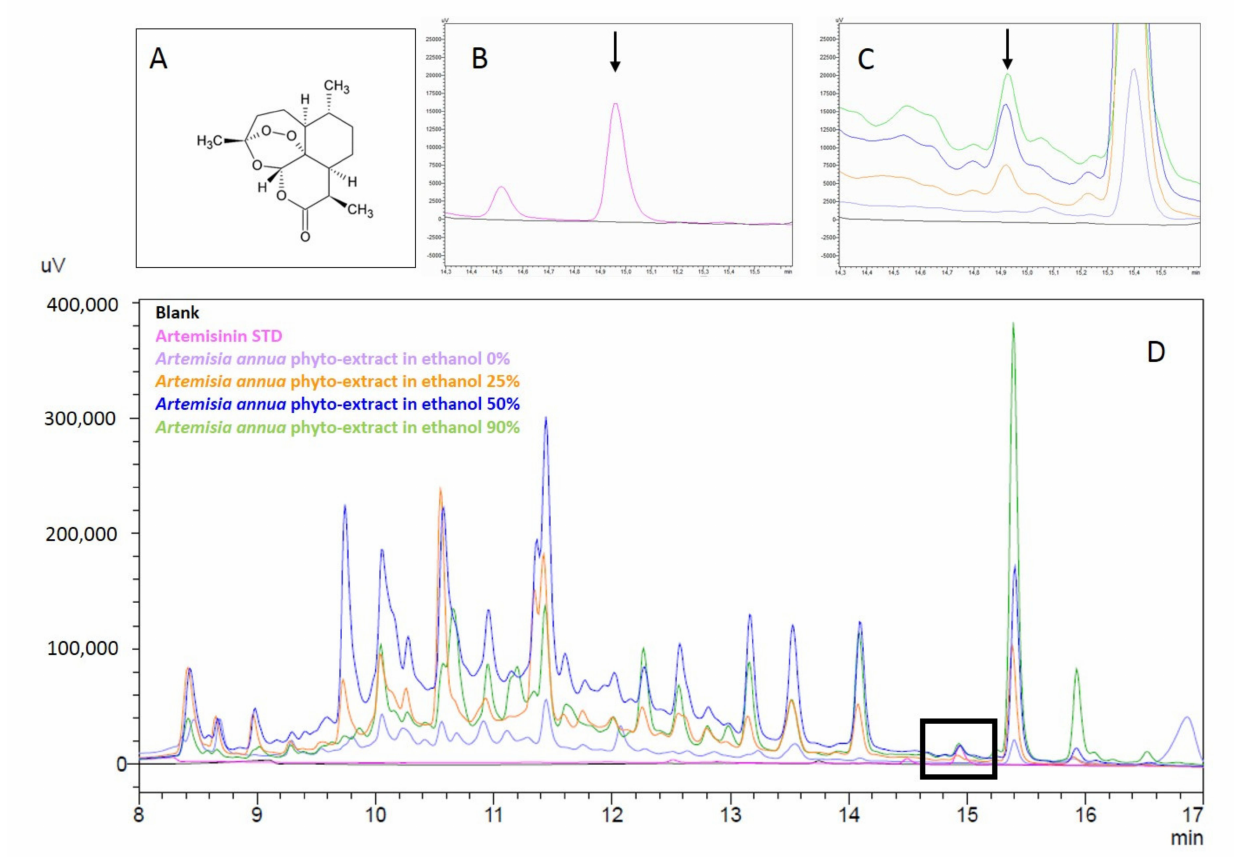
Figure 2. Chromatograms of the phyto-extracts of Artemisia annua and of the standard artemisinin. ( A ) Chemical structure of artemisinin; ( B ) details of the elution of STD artemisinin (pink) and ( C ) the ART in the AA phyto-extract samples; and ( D ) superimposed chromatograms of the ART standard and AA phyto-extracts at different concentrations of